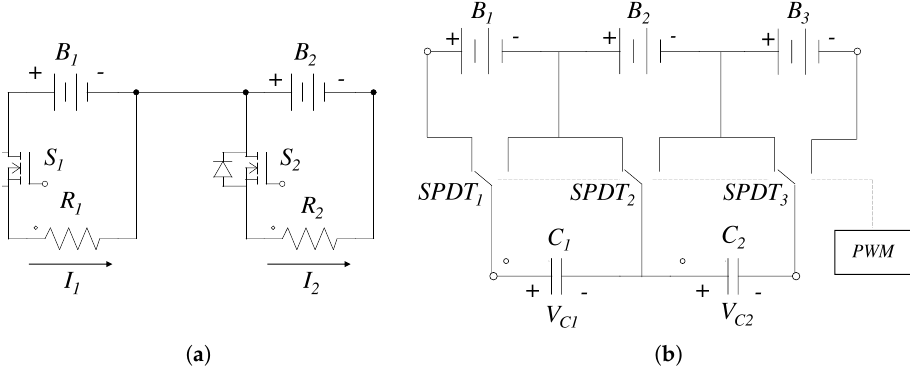
Figure 2. Classic schemes of BECs: ( a ) resistor-based equalizer; ( b ) capacitor-based